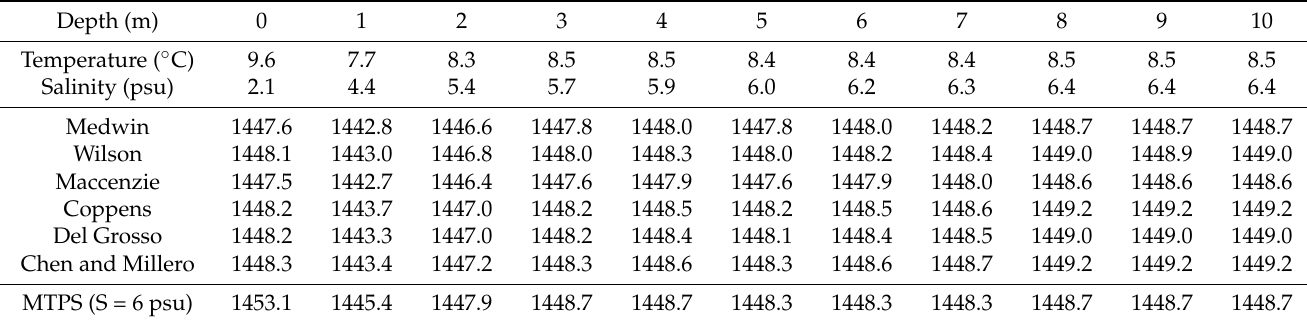
Table 7. Sound speed in water determined using selected